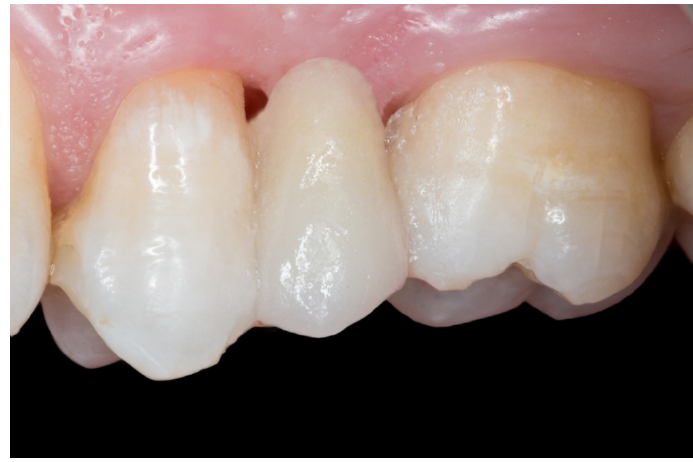
Figure 7. The FRCB after the occlusal adjustment and composite polishing.